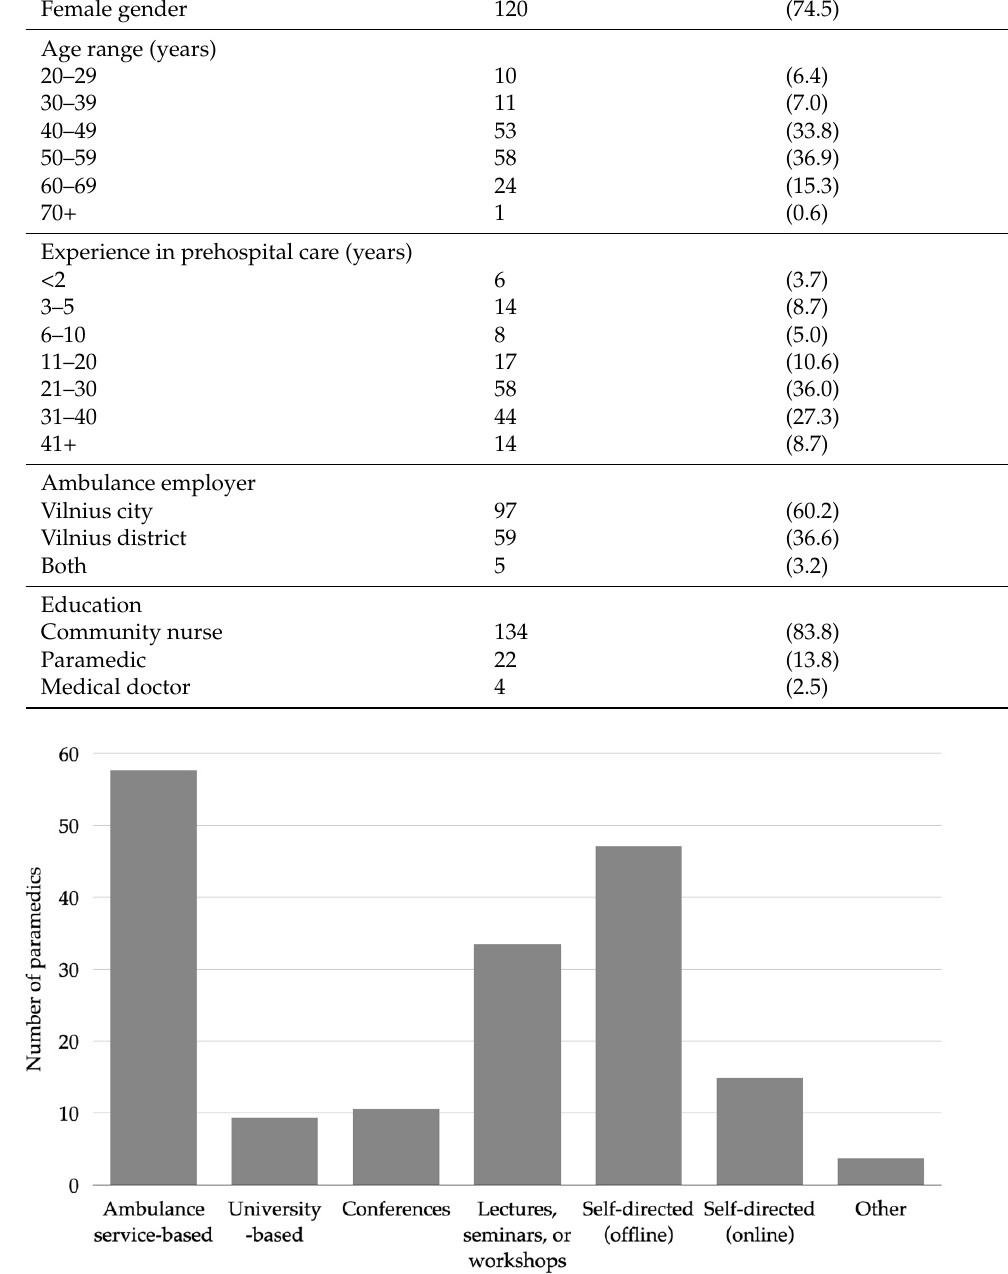
Figure 1. The sources where EMS respondents receive their primary stroke professional continuous education.